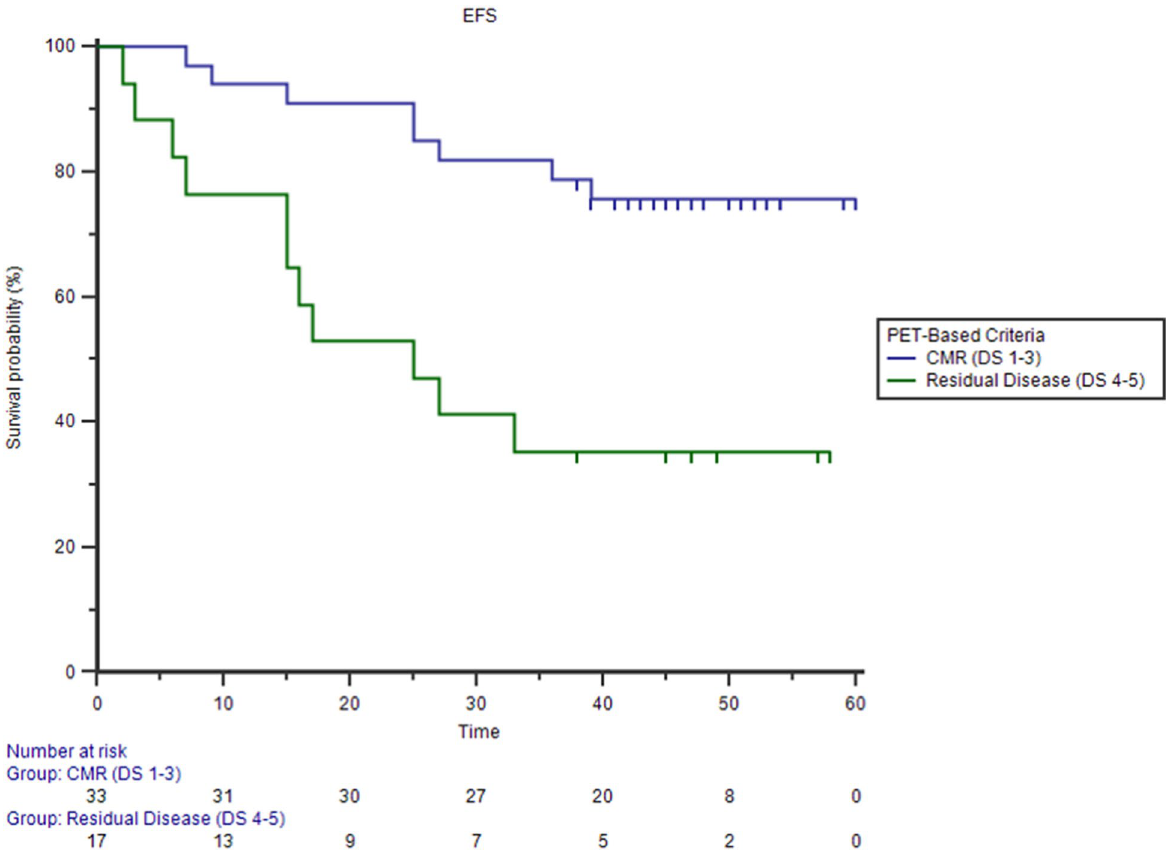
Figure 5. Kaplan–Meier estimates of event free survival (EFS) using PET-based criteria (76% vs 35% Logrank test p =